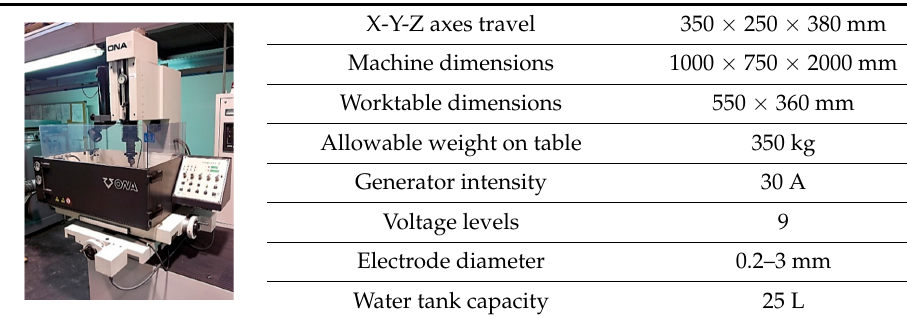
Table 2. ONA© Compact 2 characteristics.